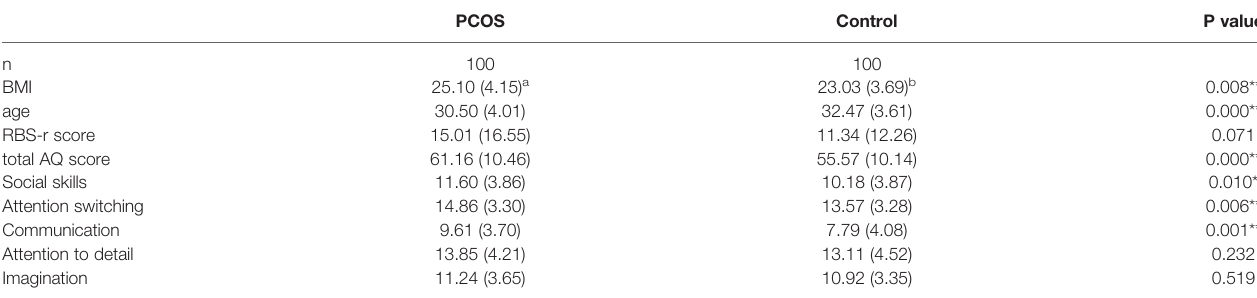
TABLE 1 | Comparisons of age, BMI, RBS-r score, total AQ score, and AQ subscale scores between the two